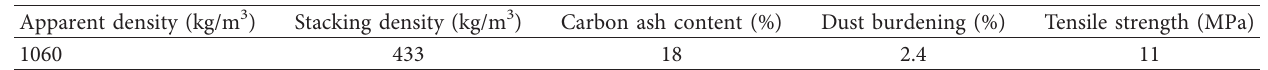
Table 4: The performance parameters of rubber particles.